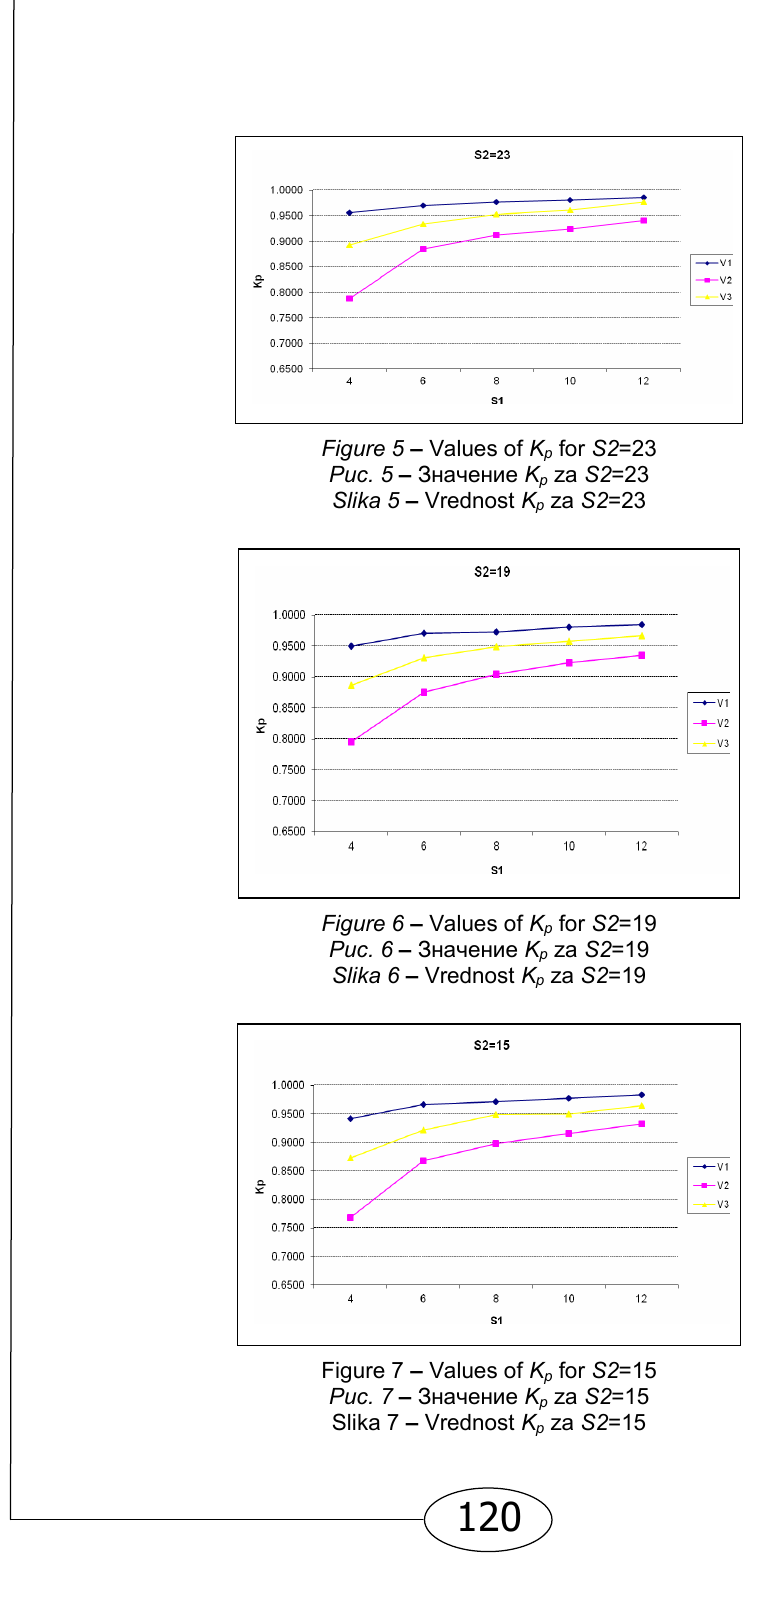
Figure 7 – Values of K p for S2 =15 Рис . 7 – Значение K p za S2 =15 Slika 7 – Vrednost K p za S2